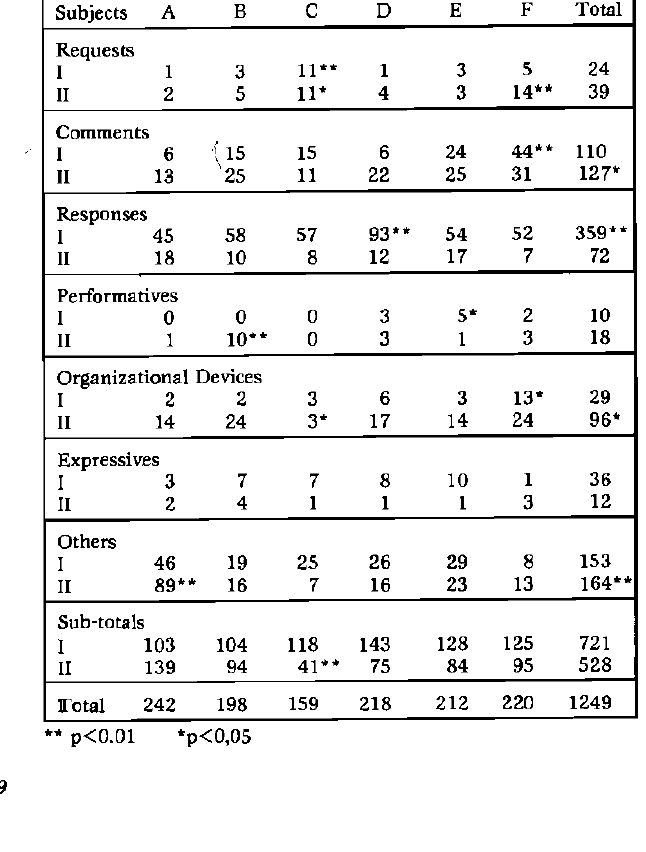
Table 1: Range of Communicative Acts for all subjects